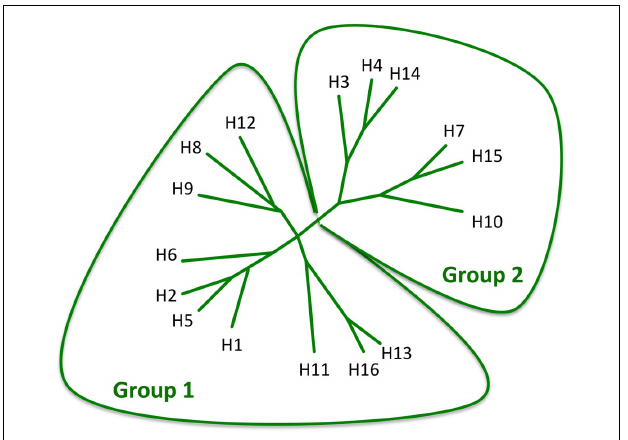
FIGURE 1 | Phylogenetic analysis of the 16 influenza HA subtypes. The diagram was adapted with permission from Nabel and Fauci (2010).